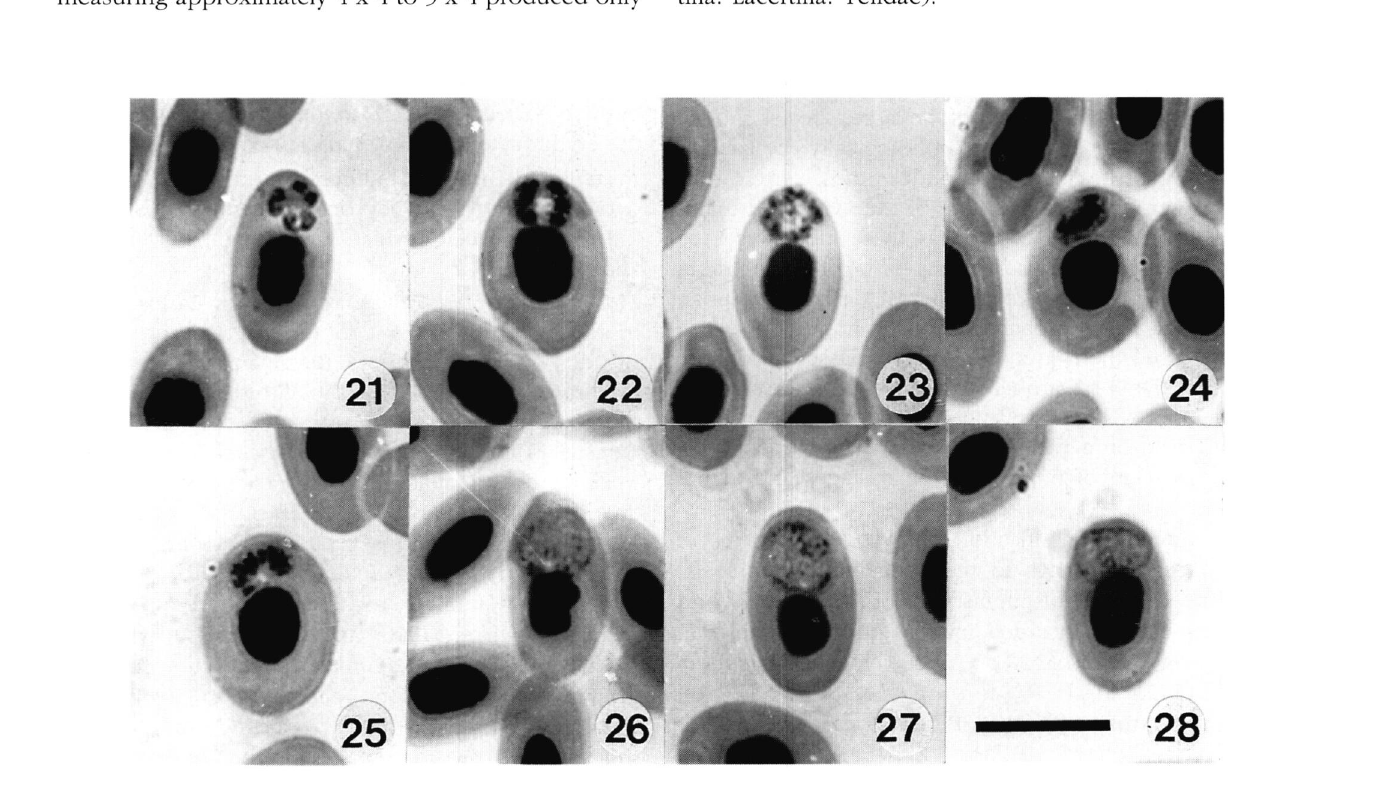
Figs 21-28. Plasmodium sp. (P. tropiduri-like) in the lizard Kentropyx calcarata. Figs 21-23. Rounded meronts. Figs 24, 25. Fan-shaped meronts. Number of merozoites produced by both forms, 4-14. Fig. 26. Mature female gametocyte. Figs 27, 28. Mature rounded and kidney- shaped male gametocytes. Bar = 10 um, and applies to all Figs. Giemsa